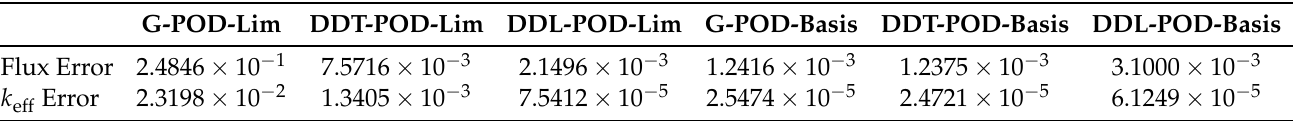
Table 5. Mean absolute maximum errors in the flux profile and k eff for solutions using POD-based reduced-order models with the limited number of snapshots and smart selection of the number of basis